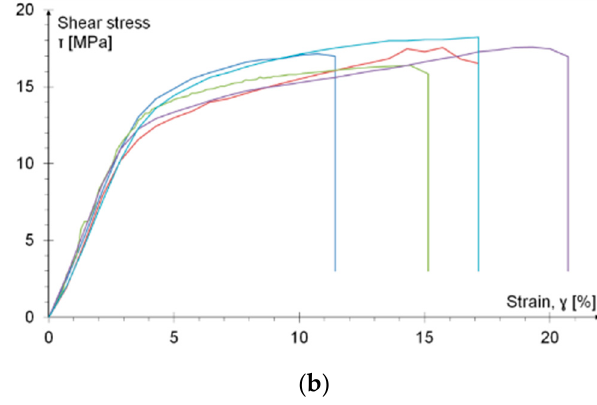
Figure 3. Single-lap joint test: ( a ) geometry of the tested specimen; ( b ) stress-strain relationship (in- directly determined). The line colors were assigned to the next five identical samples.